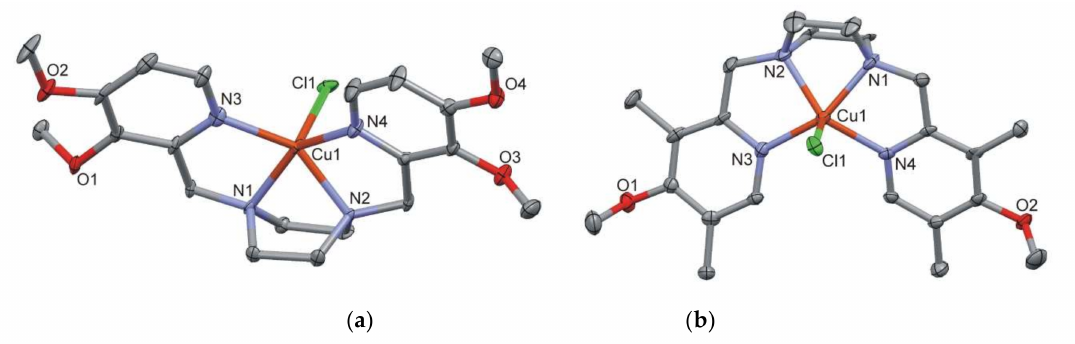
Figure 1. Molecular structures of complex cations of ( a ) 4-Cl and ( b ) 5-Cl . The X-ray crystallography of the previously determined chlorido complex, [Cu(L 1 )Cl] ClO 4 , and its corresponding acetonitrile complex, [Cu(L 1 )(CH 3 CN)](PF 6 ) 2 revealed that these molecules adopt square-pyramidal geometries